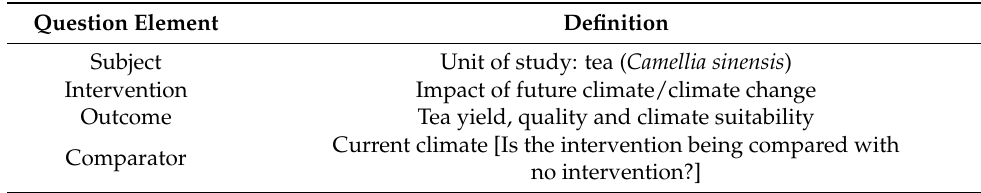
Table 1. Elements included in the present systematic